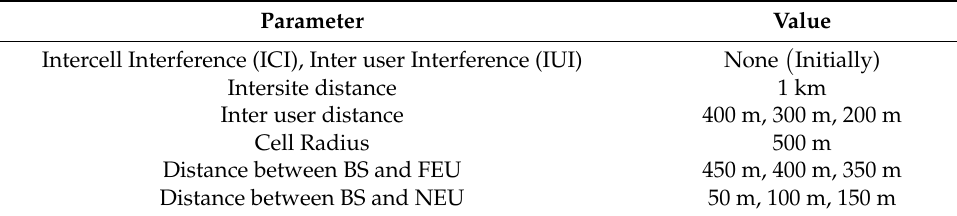
Figure 14. Seven-cell scenario with intercell interference. Table 2. System parameters for 7-cell